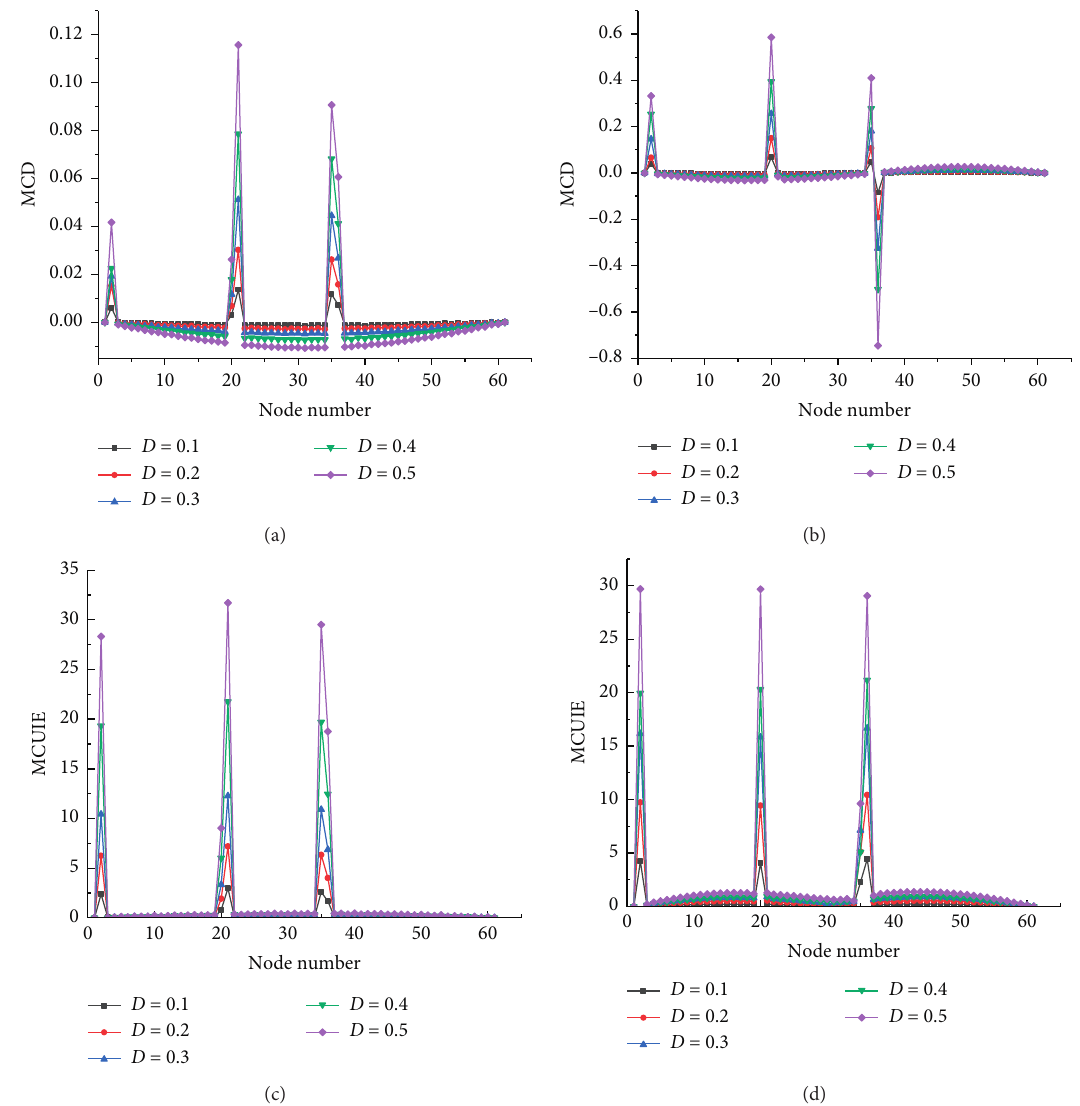
Figure 12: Damage identification results of MCD and MCUIE index of case studies 4. (a) First-order MCD. (b) Second-order MCD. (c) First-order MCUIE. (d) Second-order